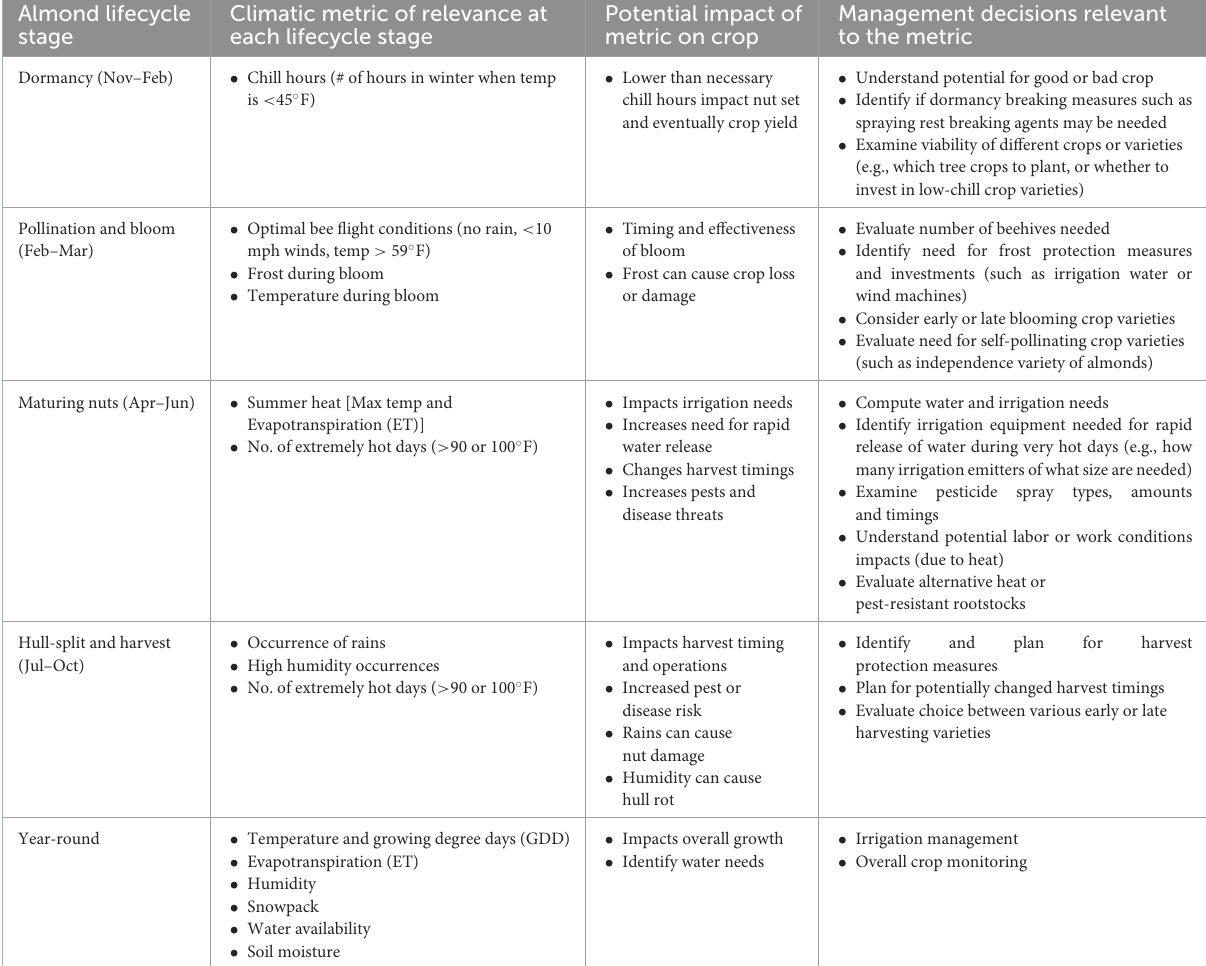
TABLE 2 Climatic metrics of relevance for the almond crop (along with potential impacts of these metrics on the crop and related management decisions) as identified by farmers and farm advisors. Almond lifecycle